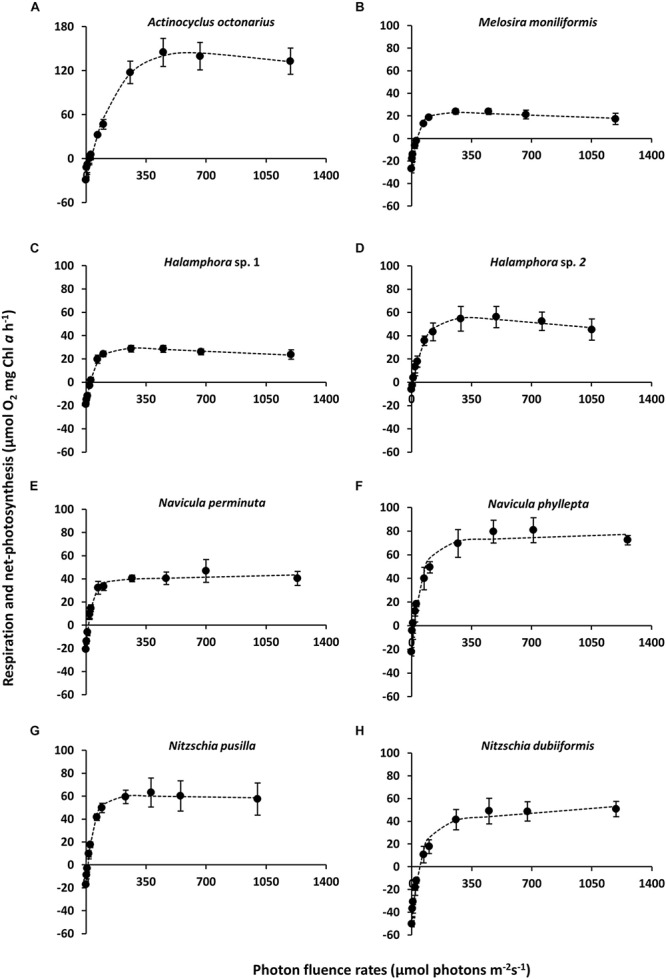
(A–H) Photosynthesis and respiration rates (μmol O2 mg–1 Chl a h–1) in relation to increasing photon flux density (μmol photons m–2s–1) of eight diatom cultures – kept at 20°C in f/2 Baltic Sea water medium, 15SA – measured by oxygen evolution with optodes. Data represent mean values ± SD (n = 3). (A)
Actinocyclus octonarius, notice differently sized axis; (B)
Melosira moniliformis; (C)
Halamphora sp. 1; (D)
Halamphora sp. 2; (E)
Navicula perminuta; (F)
Navicula phyllepta; (G)
Nitzschia dubiiformis; (H)
Nitzschia pusilla.